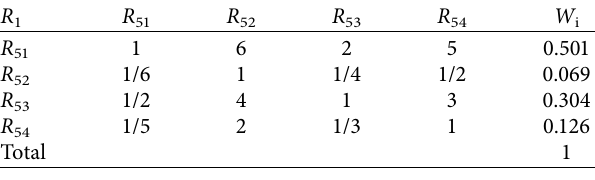
Table 8: Weight of teaching satisfaction in second-level